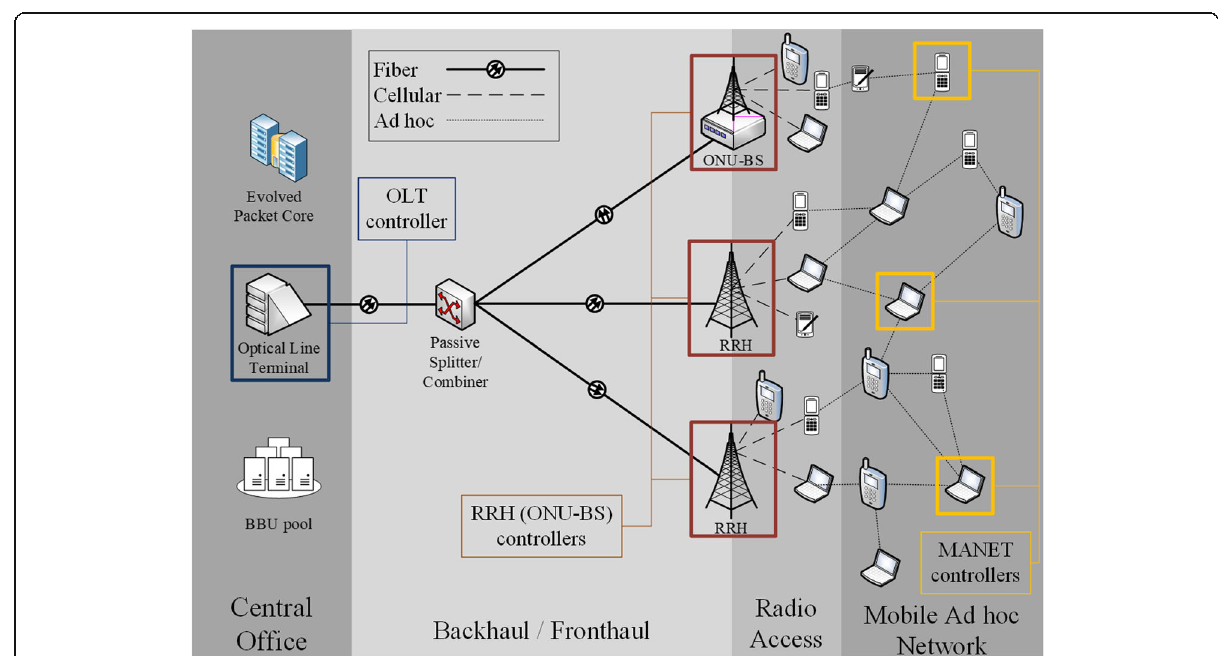
Fig. 7 Distributed SDN deployment and implementation in the FiWi-MANET